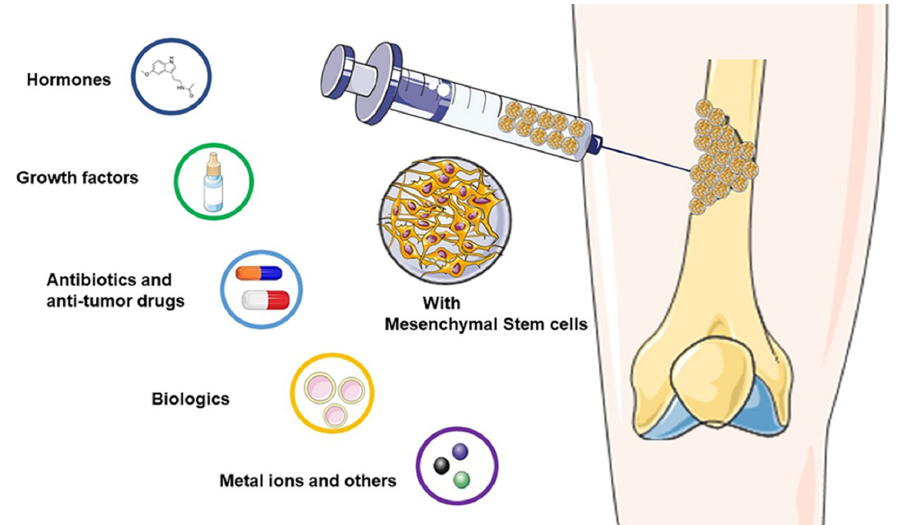
Figure 2. Microspheres as carriers in bone tissue engineering. Table 1. Products loaded by microspheres for bone tissue engineering .